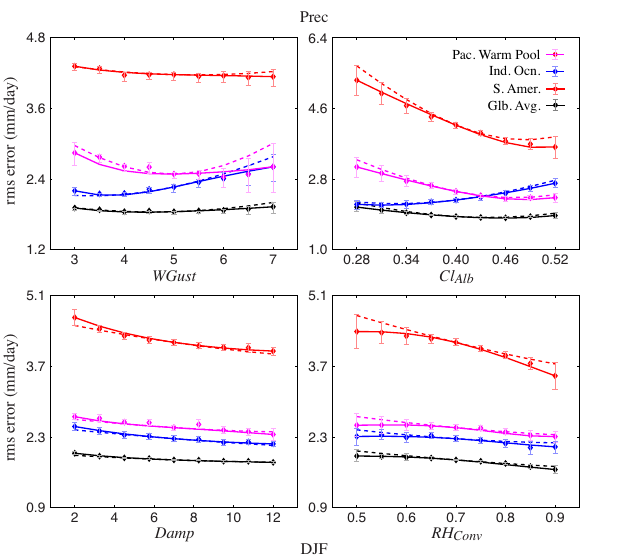
Fig. 9. Root-mean-square precipitation error of the AGCM regres- sion coefficients for the El Niño 3.4 index in December–February for target regions relative to the CPC Merged Analysis of Precip- itation data set. The AGCM values are compared to the quadratic metamodel reconstruction based on the endpoints for each param- eter, and to its linear counterpart. Global average in black, Pacific Warm Pool in magenta, Indian Ocean basin in blue and South Amer- ica in red. Units on abscissa are ms − 1 for WGust, days for Damp and nondimensional for Cl Alb and RH Conv . Error bars estimate the spread of the RMS error within the ten ensemble members ( ± 1 stan- dard error of the